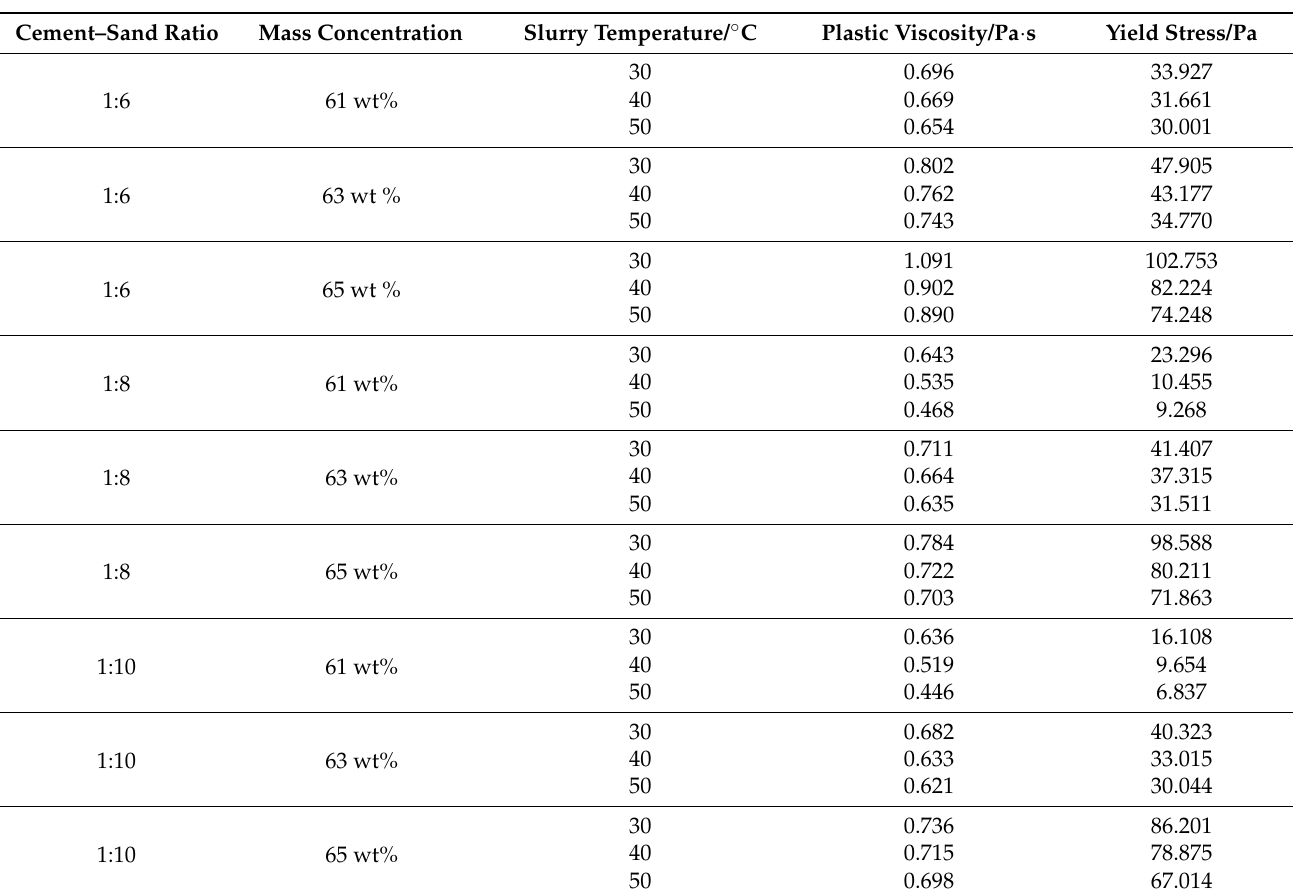
Table 4. Plastic viscosity and yield stress of UCPB.